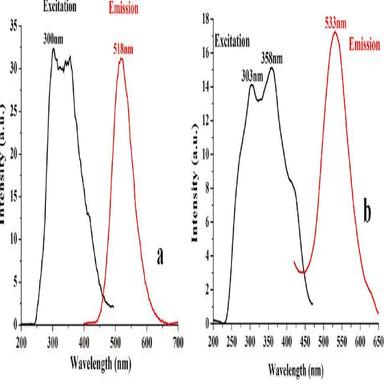
The excitation and emission spectras of (a) Yb1.98Lu0.02Sn2O7 (b) Yb1.90Eu0.10Sn2O7.